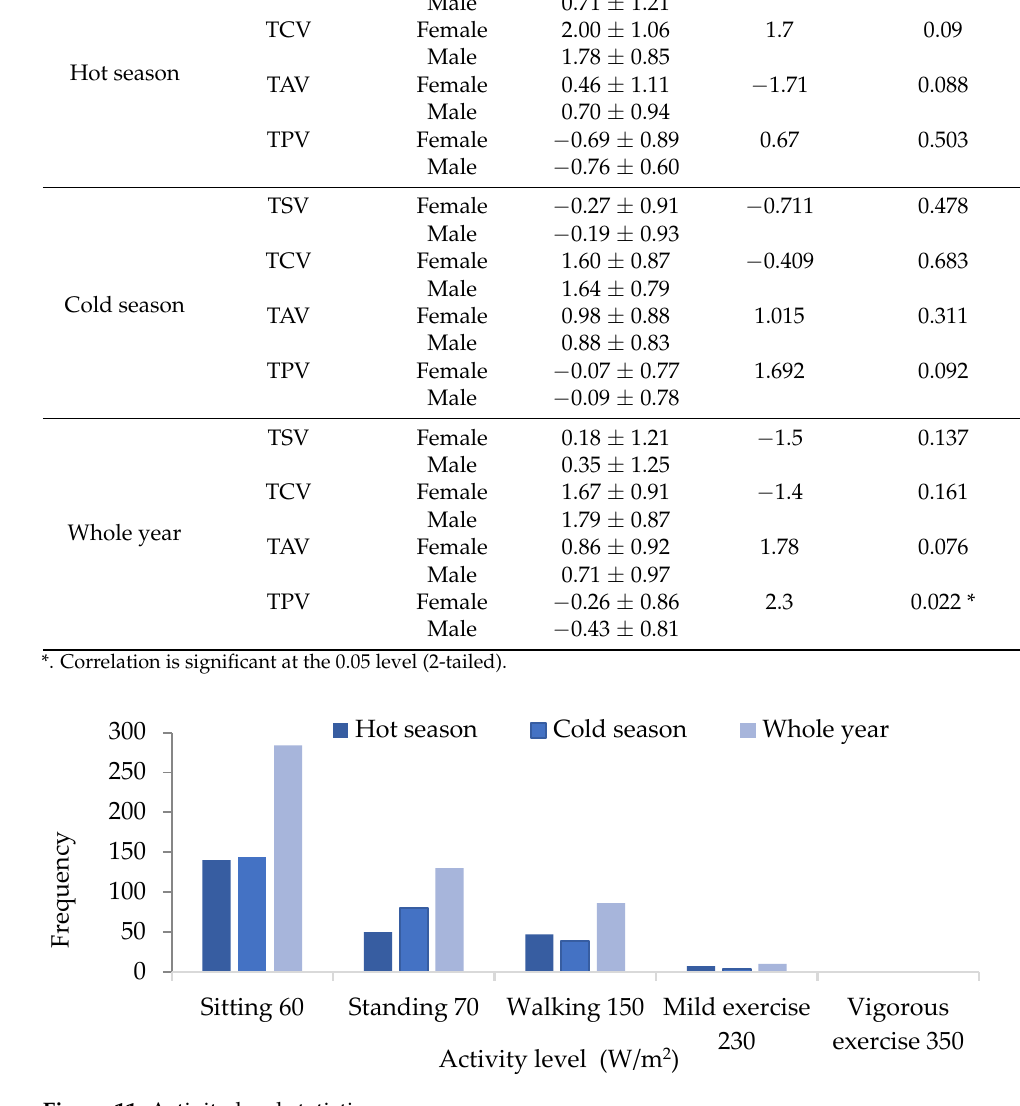
Figure 11. Activity level statistics. Table 9. Analysis of differences in the effect of activity levels on weather perception.